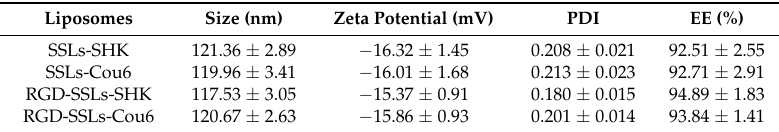
Figure 2. Schematic illustration of RGD-modified shikonin-loaded liposomes (RGD-SSLs-SHK) ( A ); The particle size distribution of RGD-SSLs-SHK ( B ); and TEM image of RGD-SSLs-SHK ( C ). Table 1. Characterization of liposomes (mean ± SD, n = 3). Table 1. Characterization of liposomes (mean ± SD, n =